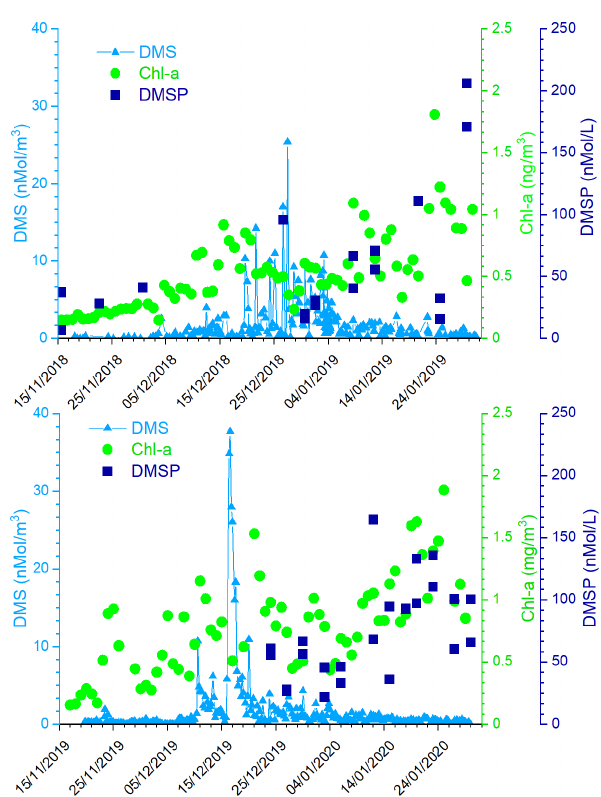
Figure 3. Time series of measured atmospheric DMS, DMSP in sea water, and satellite-derived Chl- a (daily, area-averaged concentra- tion in the region 162.5977 ◦ E, 77.666 ◦ S; 171.2109 ◦ E, 72.2168 ◦ S, corresponding to a rectangle 600 × 300km) in the two